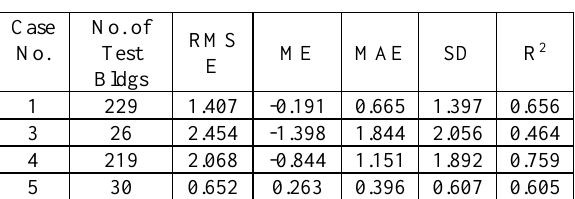
Table 4. Descriptive Statistics for Maximum Height Extraction (Per